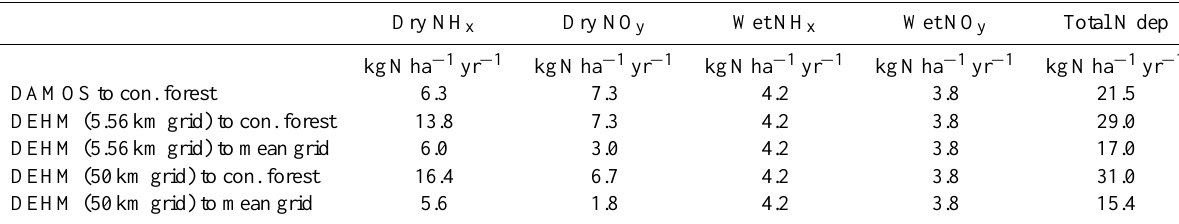
Table 5. An example of the modelled annual deposition (dry and wet) of NH x and NO y to a coniferous forest in Denmark. The first row presents the deposition estimated by the DAMOS system. The next four rows show the estimates from the DEHM model alone, in the 5.56km grid and 50km grid, respectively. The DEHM results are extracted for a coniferous forest or as mean over all land-use types in the specific grid cell. Note that the differences between the numbers to the forest and the mean for the grid will depend on e.g. the relative occurrence of different land-use types in the specific grid